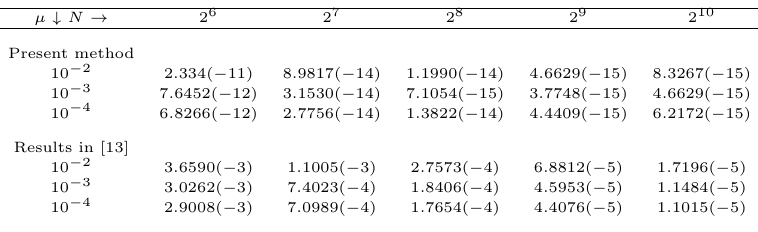
Table 4. Maximum absolute errors in the solution of Example 1